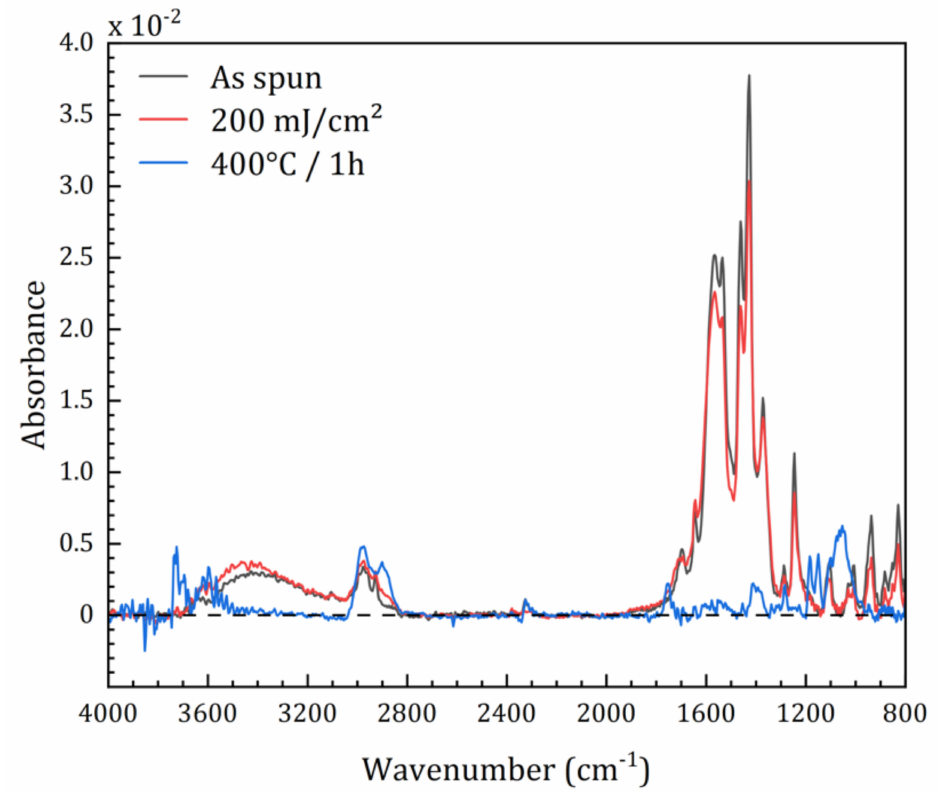
Figure 1. Transmission FTIR spectra of HfO 2-DUV thin films deposited by spin-coating and analyzed after deposition, after DUV irradiation (200 mJ/cm 2 ) and after heat treatment at 400 ◦ C. The intensity of the bands in the 1200–1800 cm − 1 region decreases slightly after irradiation with a moderate dose (corresponding to the dose used to photopattern